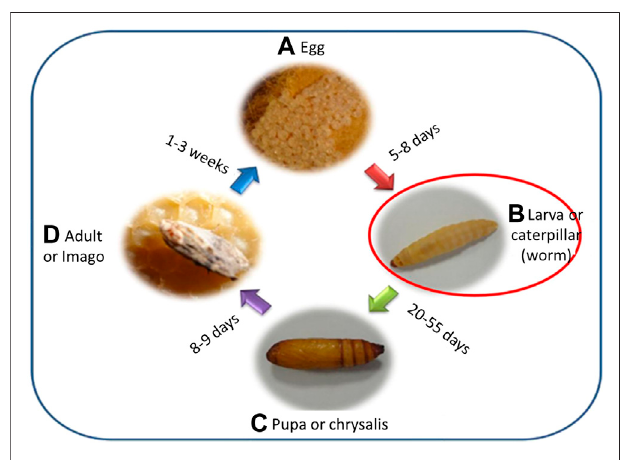
FIGURE 1 | Biological cycle of G. mellonella . Source: Lucila Galan (Galán, 2012). (A) . Egg, (B) . Larva or caterpillar (worm), (C) . Pupa or chrysalis, (D) . Adult or